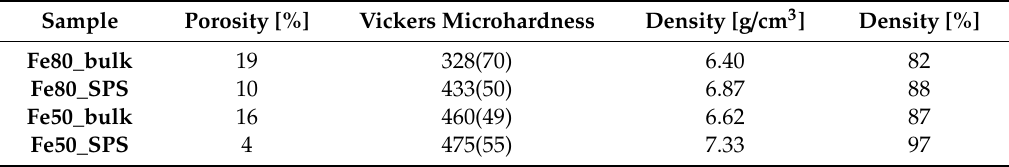
Table 2. The porosity, Vickers microhardness, the absolute and relative density of the samples Fe50 and Fe80 before and after the SPS